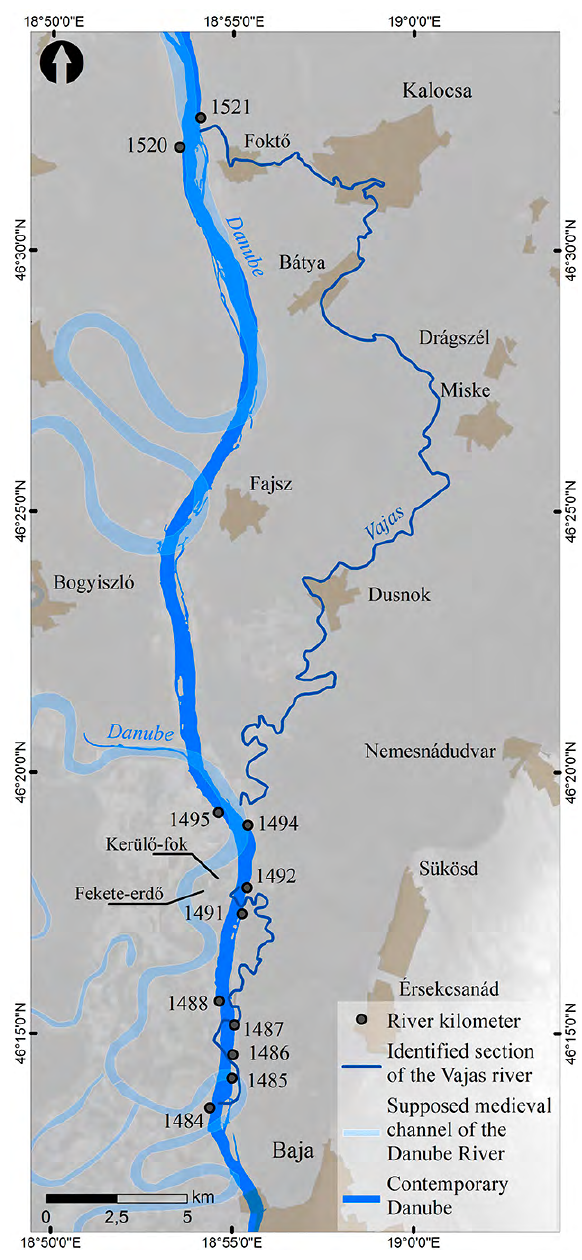
Figure 3. The channel of the Vajas 1 and